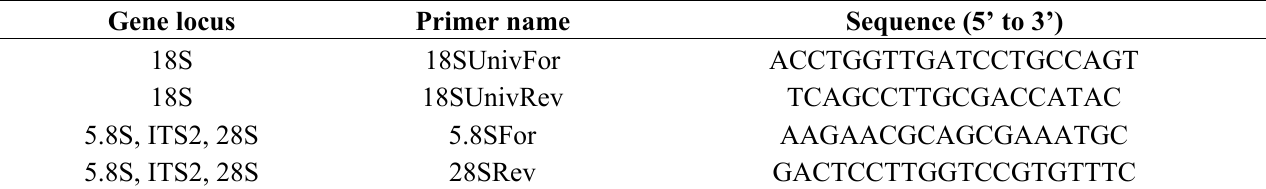
Table 3. Primer name, sequence and corresponding gene locus used in the identification of strains. Gene